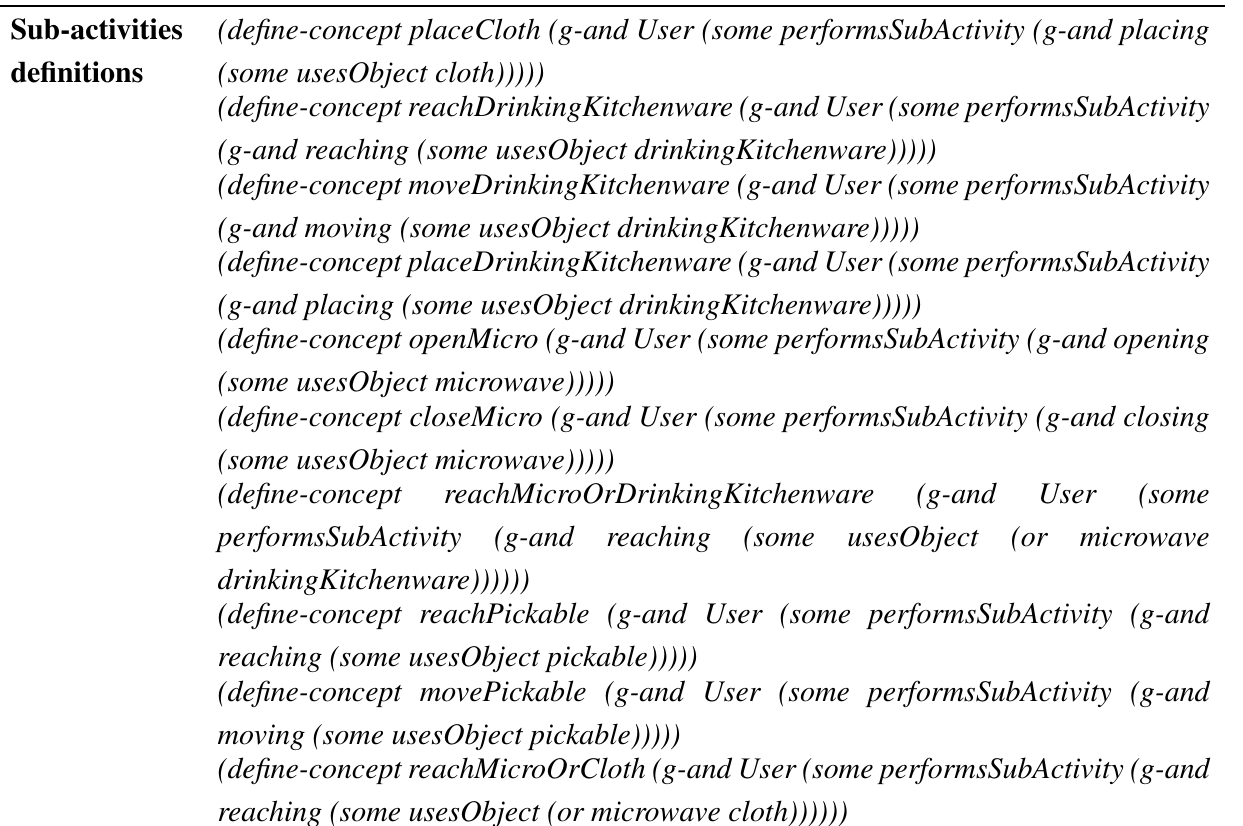
Table 3. Excerpt of fuzzy concepts used in the rules (Part